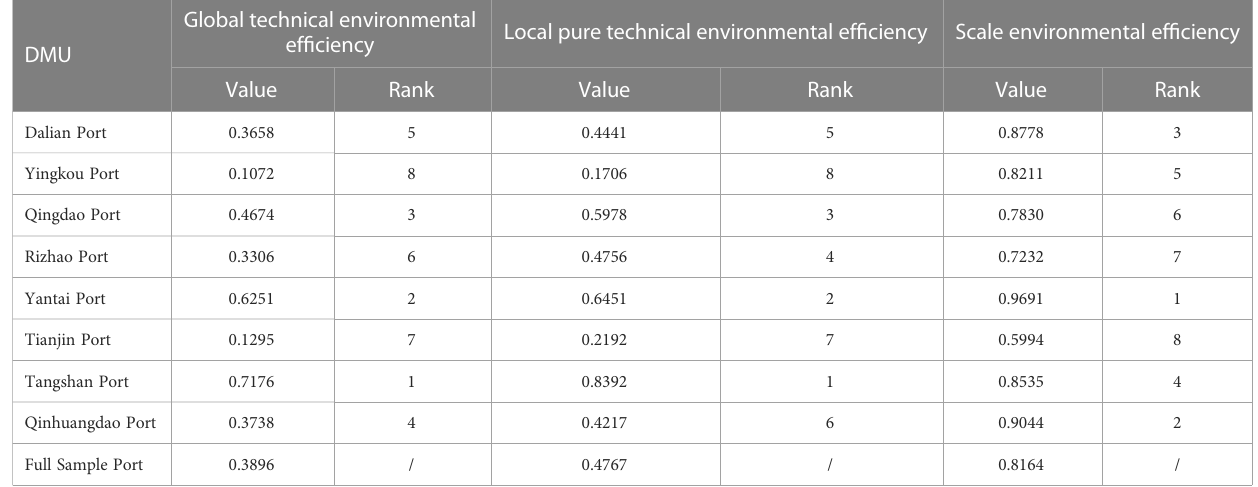
TABLE 4 The average value and rank of the environmental ef fi ciency of the eight ports from 2005 to 2020.